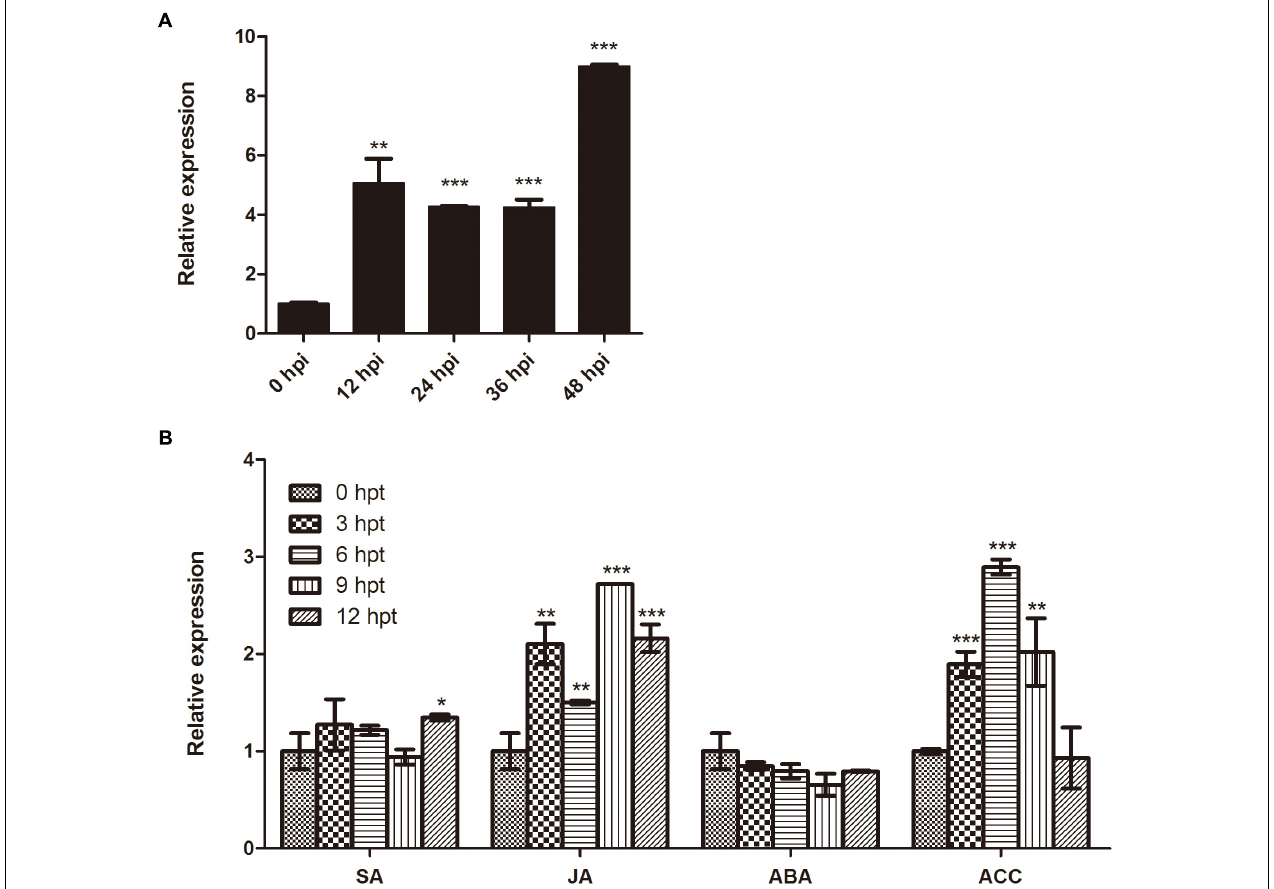
FIGURE 2 | Expression of BnaMPK3 in B. napus during infection of S. sclerotiorum and activation of plant defense responses. (A) Response of BnaMPK3 to S. sclerotiorum infection in B. napus . Relative expression levels of BnaMPK3 in B. napus were determined by real-time quantitative PCR at 0, 12, 24, 36, and 48 h post S. sclerotiorum inoculation (hpi). (B) Expression of BnaMPK3 during activation of defense responses in B. napus . Relative expression levels of BnaMPK3 in B. napus were determined by real-time quantitative PCR at 0, 3, 6, 9, and 12 h post various chemicals treated. SA, salicylic acid; MeJA, methyl jasmonate; ABA, abscisic acid; ACC, 1-aminocyclopropane-1-carboxylic acid. Values are means of three replicates. The error bars show the standard deviation. The significances of the gene expression differences between each time point and the 0-h time point are indicated (Student’s t -test, ∗∗∗ P < 0.001, ∗∗ 0.001 < P < 0.01 or ∗ 0.01 < P <